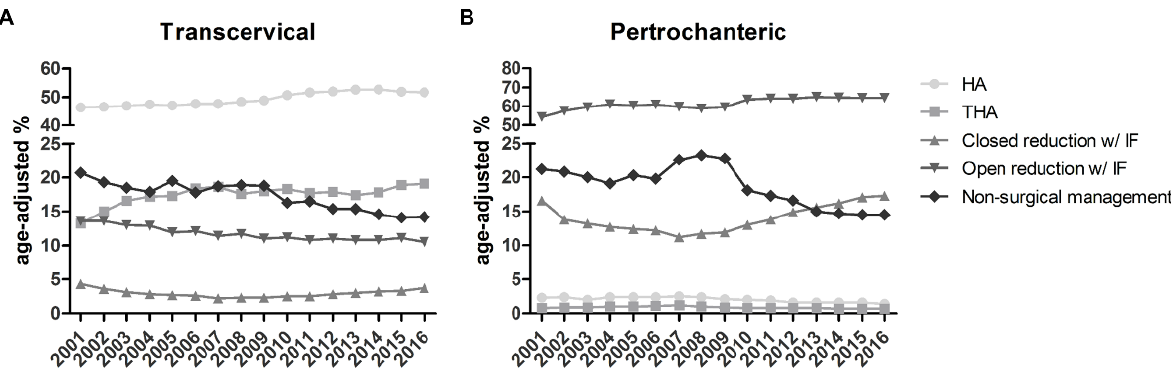
Figure 5. Age-adjusted relative frequency of treatments of transcervical ( A ) and pertrochanteric ( B ) fractures between 2001 and 2016. HA, hemiarthroplasty; THA, total hip arthroplasty; w/ IF, with internal fixation; w/o IF, without internal fixation.